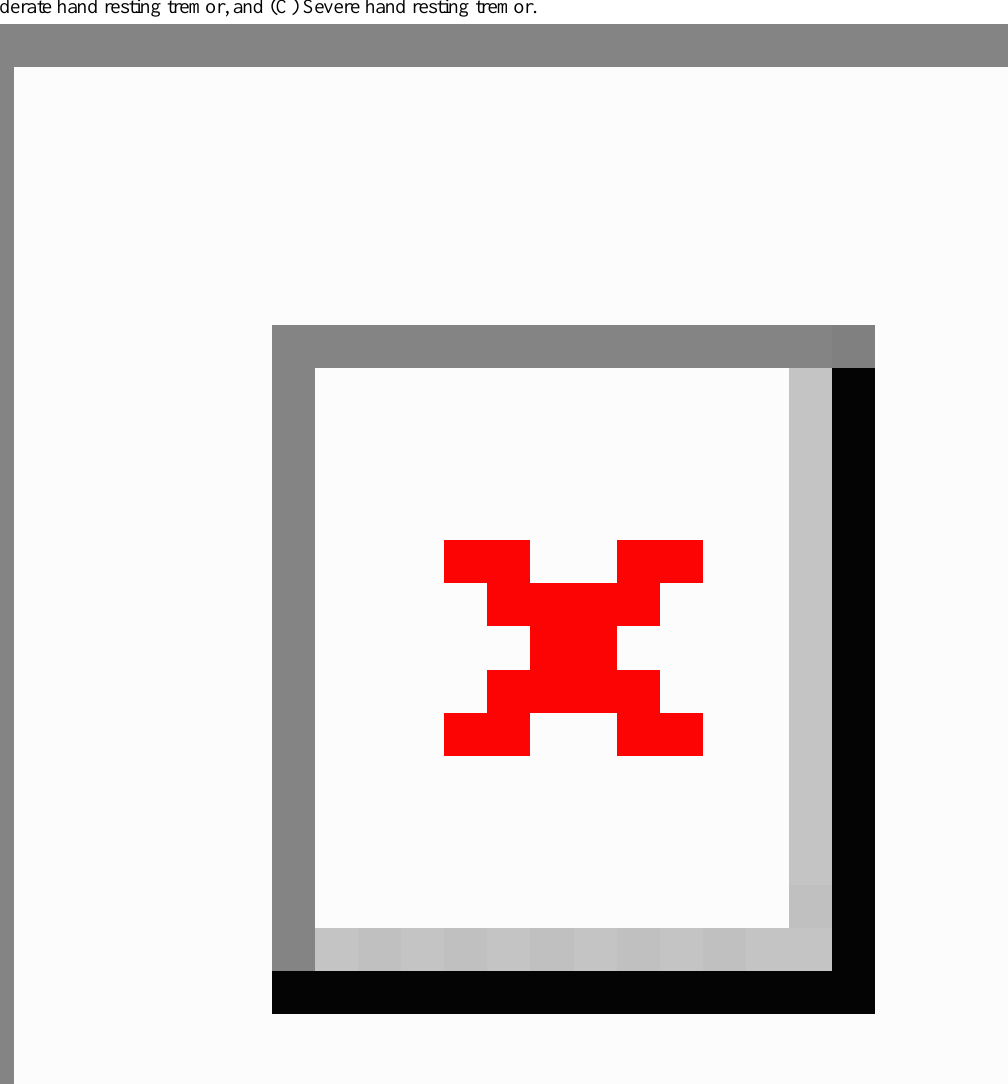
Figure 5. Acceleration waveform and power spectrum density (PSD) plot of hand resting tremor of different severity: (A) Mild hand resting